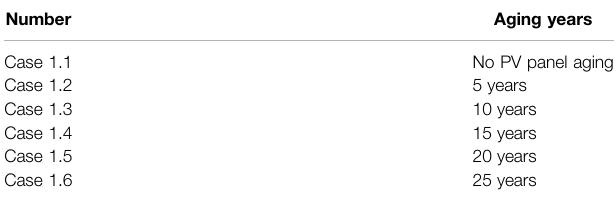
TABLE 5 | Case settings for geographical location settings. Number